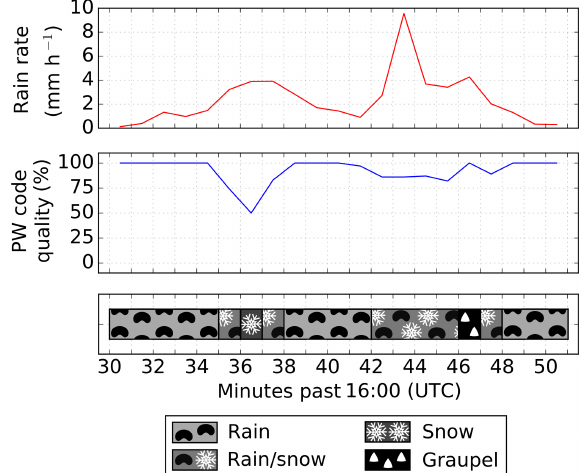
Figure 13. Rain rate, present weather code quality index, and hy- drometeor type during a graupel shower in Reading, England, on 25 April 2017. The event was recorded by a Thies LPM at the Read- ing University Atmospheric Observatory. Conical graupel was also observed from a nearby building (approximately 500m away) by a qualified meteorologist between 16:30 and 16:45UTC. Rain rate is the liquid equivalent for periods of solid hydrometeors as recorded by a Thies LPM disdrometer. Hydrometeor type is shown based on the present weather code (WMO Table 4680) recorded by the Thies LPM. The instrument struggles to diagnose the graupel and instead outputs a present weather code of snow and mixed rain–snow pre-